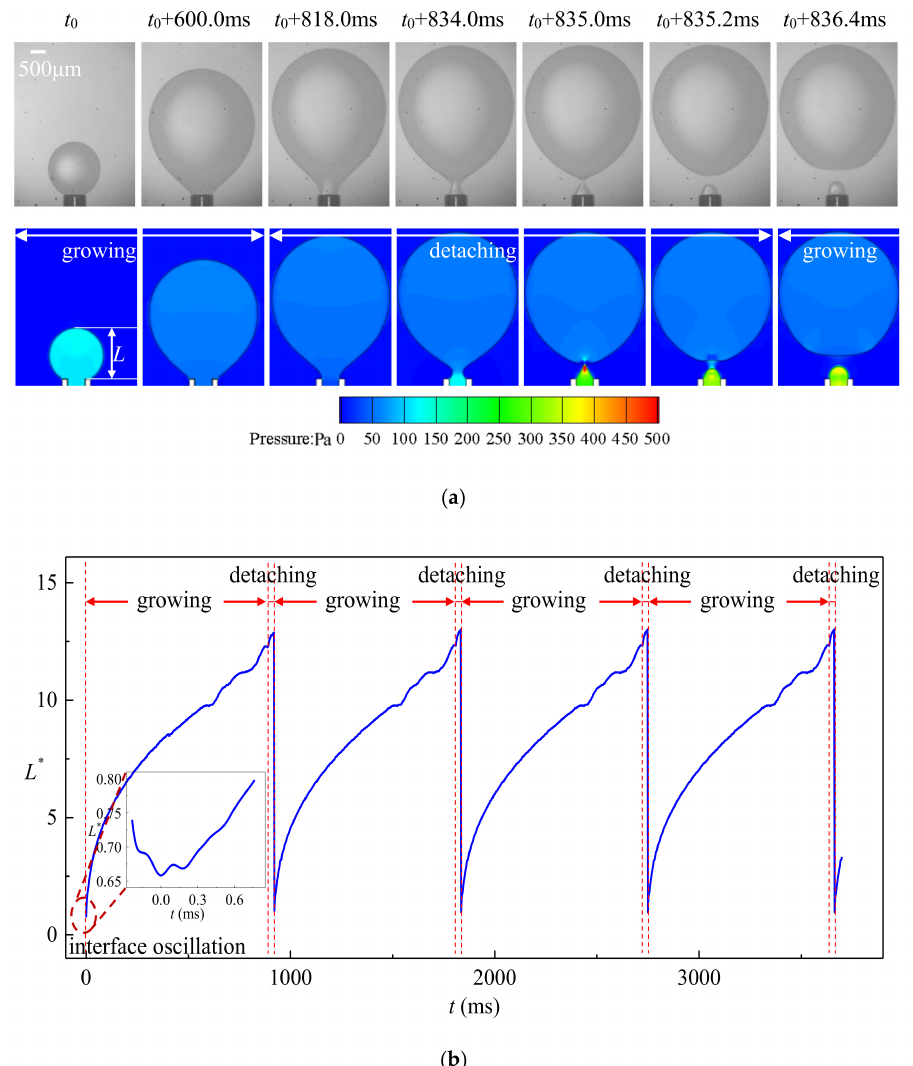
Figure 5. Typical dripping regime ( q d = 90 mL / h, We = 0.027, Bo = 0.0038): ( a ) experimental snapshots and numerical simulation; ( b ) variation of droplet length reconstructed from numerical